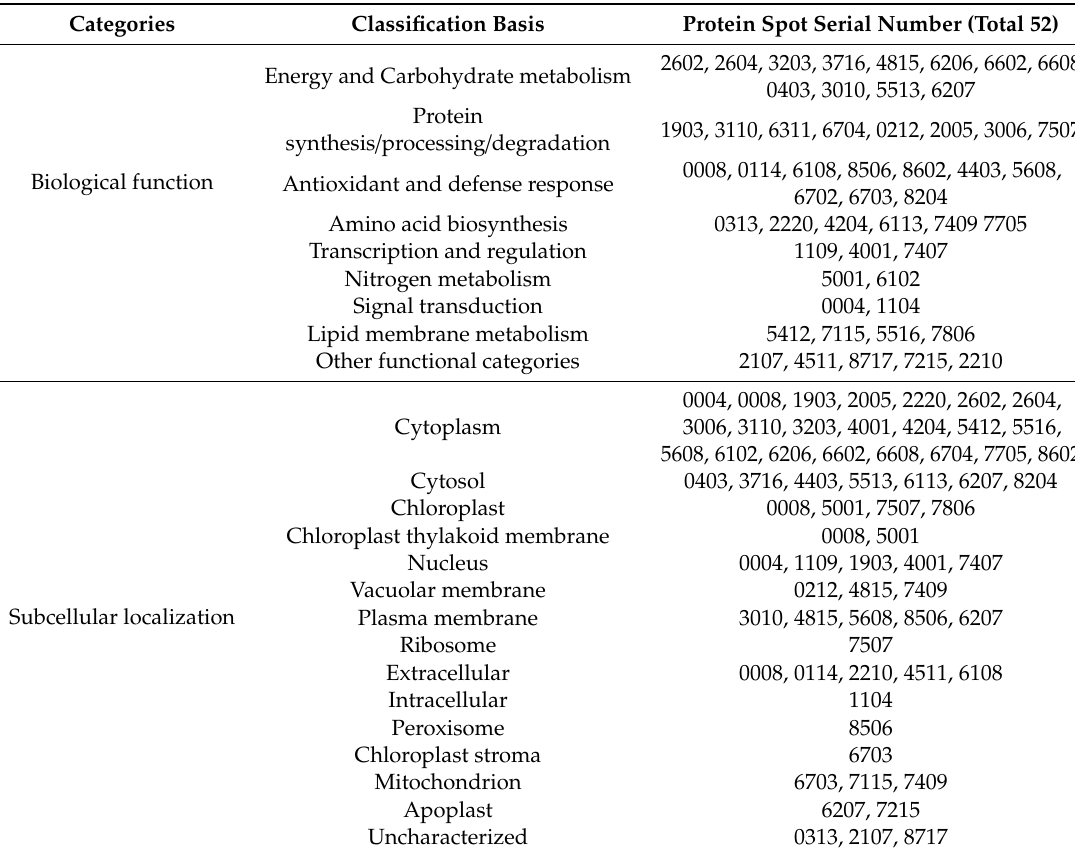
Table 5. The 52 identified proteins in the root of sorghum seedlings within functional categories based on their biological functions and subcellular